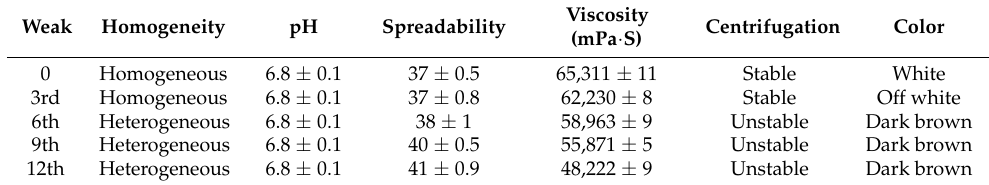
Table 10. Stability of nanoemulgel at 48 ◦